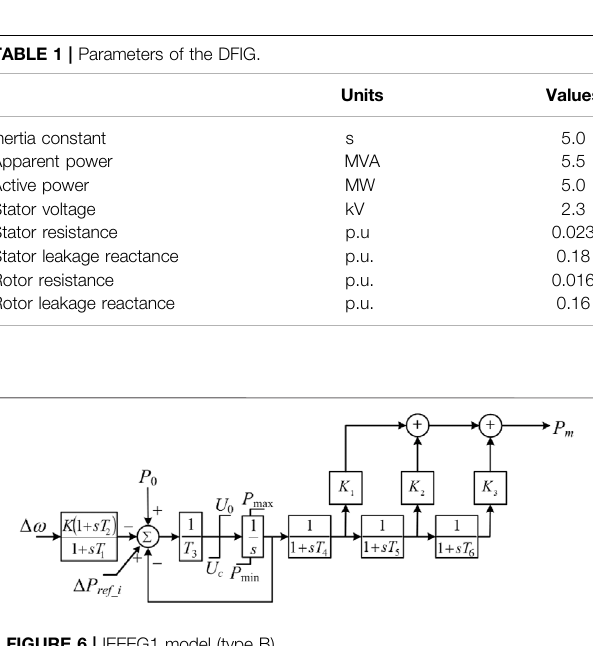
FIGURE 6 | IEEEG1 model (type